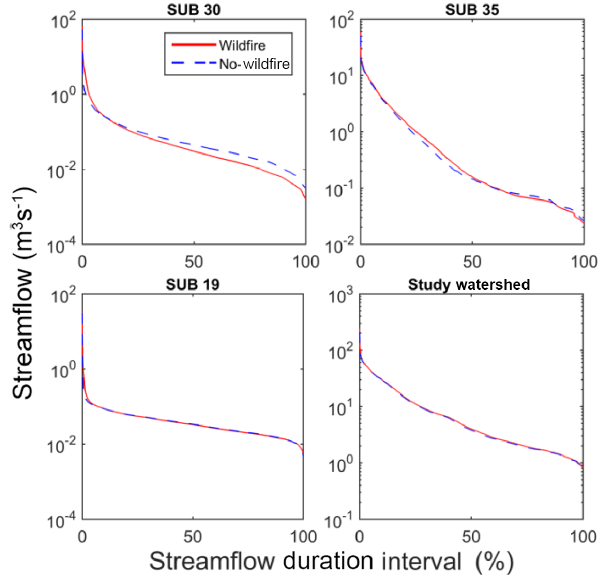
Figure 9. Flow duration curves for select sub-watersheds as well as the entire study watershed. Sub-watershed area and percentage of burned area for sub-watersheds 30, 35, 19, and the study watershed are 11km 2 and 79%; 269km 2 and 16%; 90km 2 and 10%; and 2732km 2 and 14%,